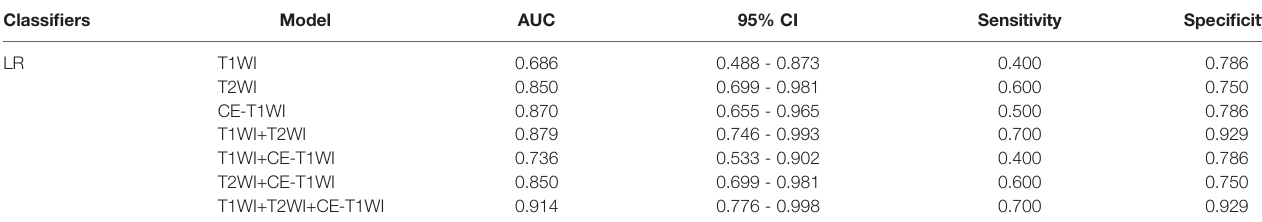
TABLE 7 | The ROC curve of different models of LR-classi fi er in the validation cohort.